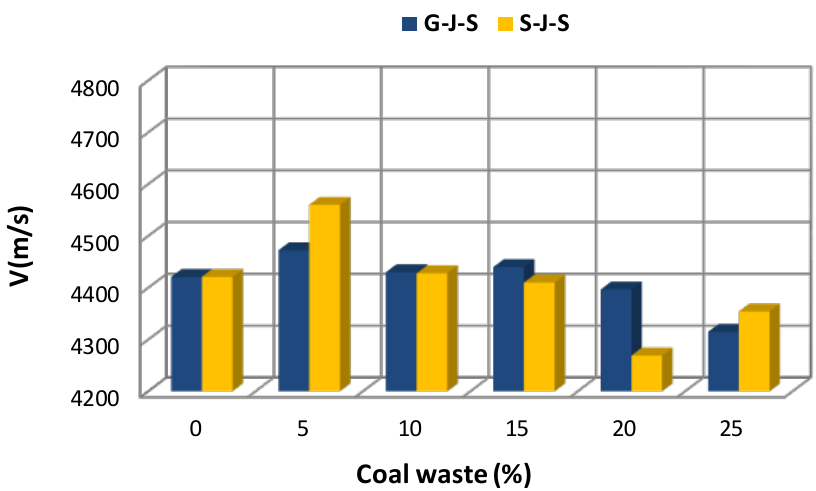
Figure 5. Effect of replacing aggregates with coal waste at the age of 7 days.